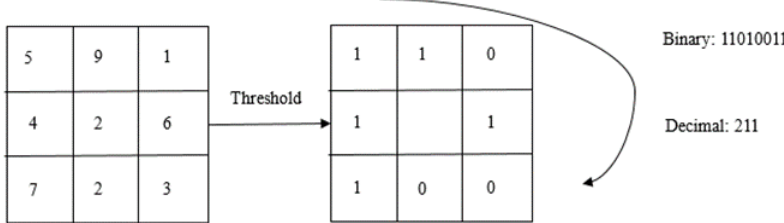
Figure 1. LBP principle. The center is 2; the numbers that are larger than 2 become 1, while the numbers that are smaller than 2 become 0.